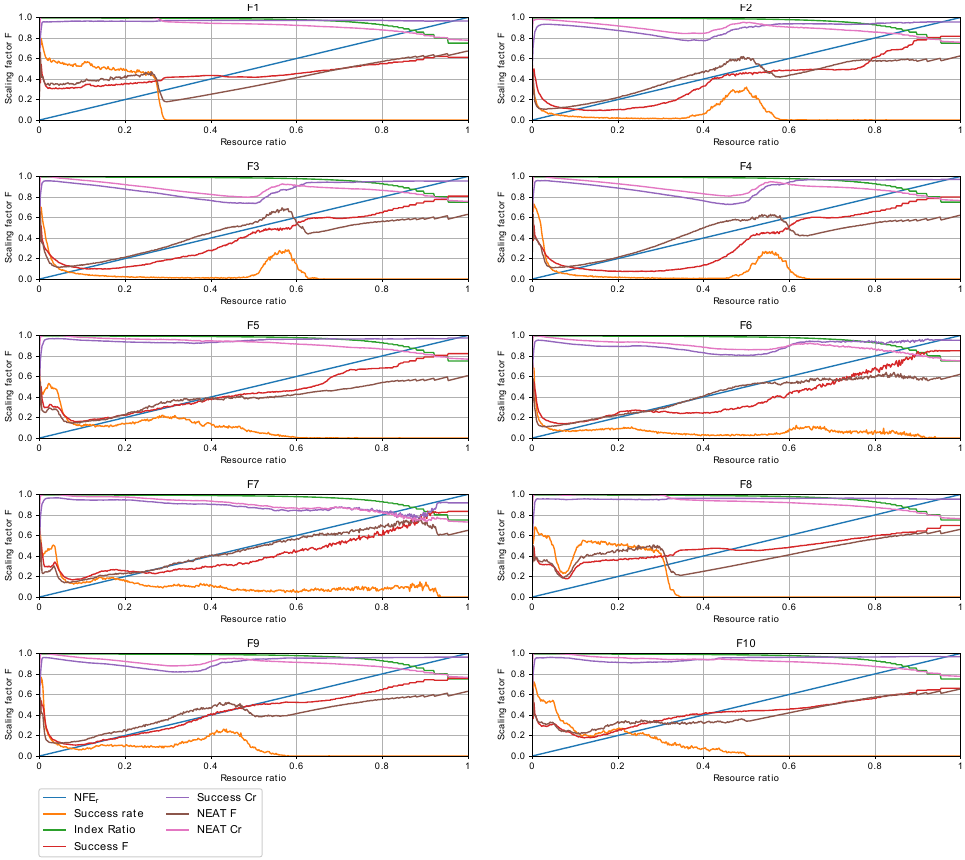
Figure 4. Process of parameter adaptation with solution from run 49, CEC 2021 test functions, 10 D , biased, rotated and shifted